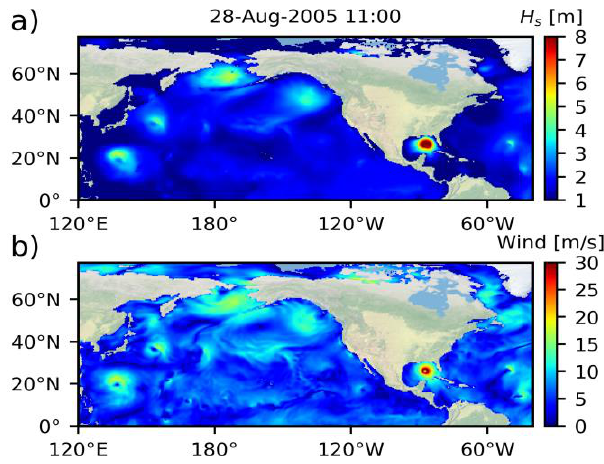
Fig. 5. Snapshots of simulated global significant wave height with WWIII (a) and CFSR surface wind (b) during Hurricane Katrina on August 28, 2005.